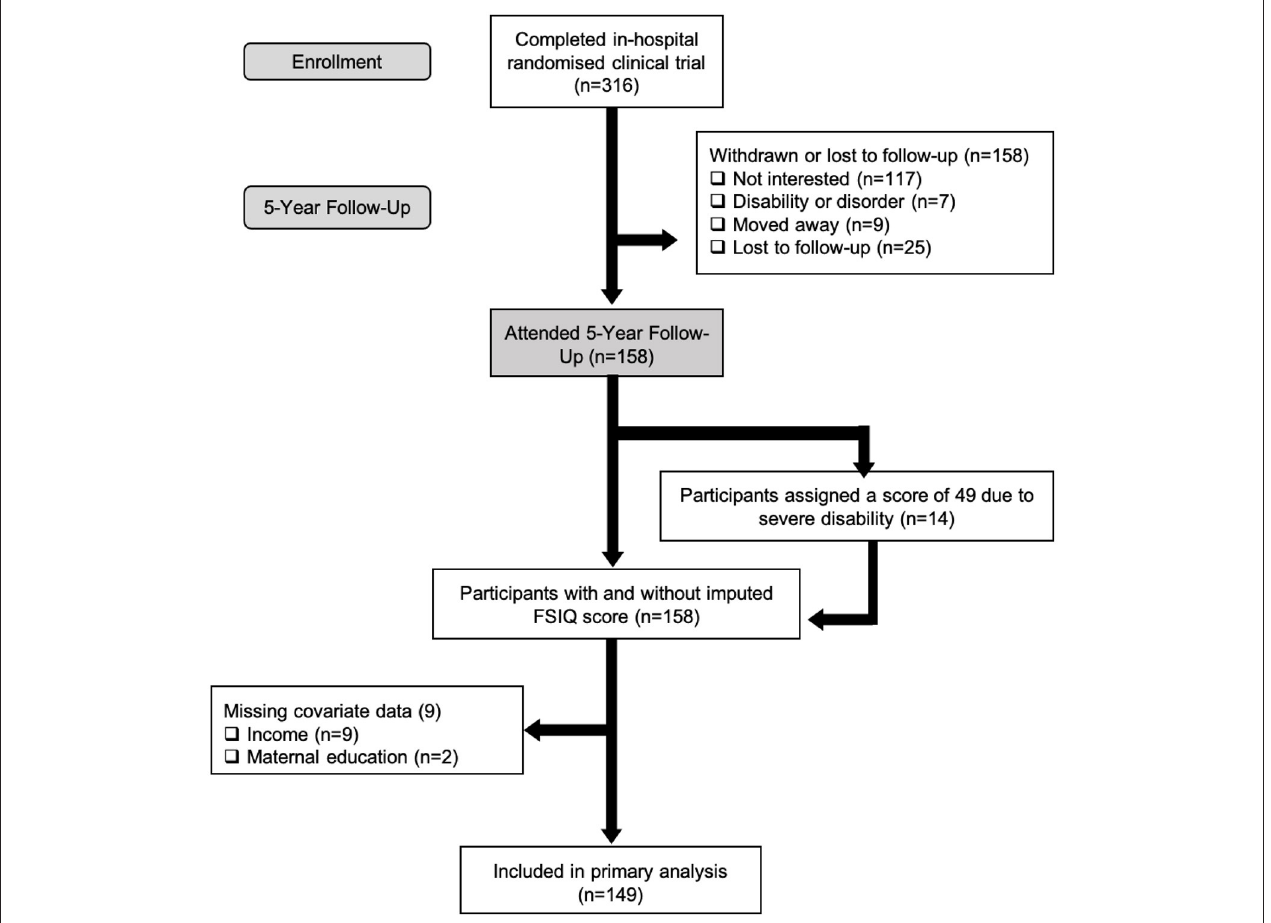
FIGURE 1 | Flow of VLBW participants through the randomized clinical trial from initial enrollment to inclusion in primary